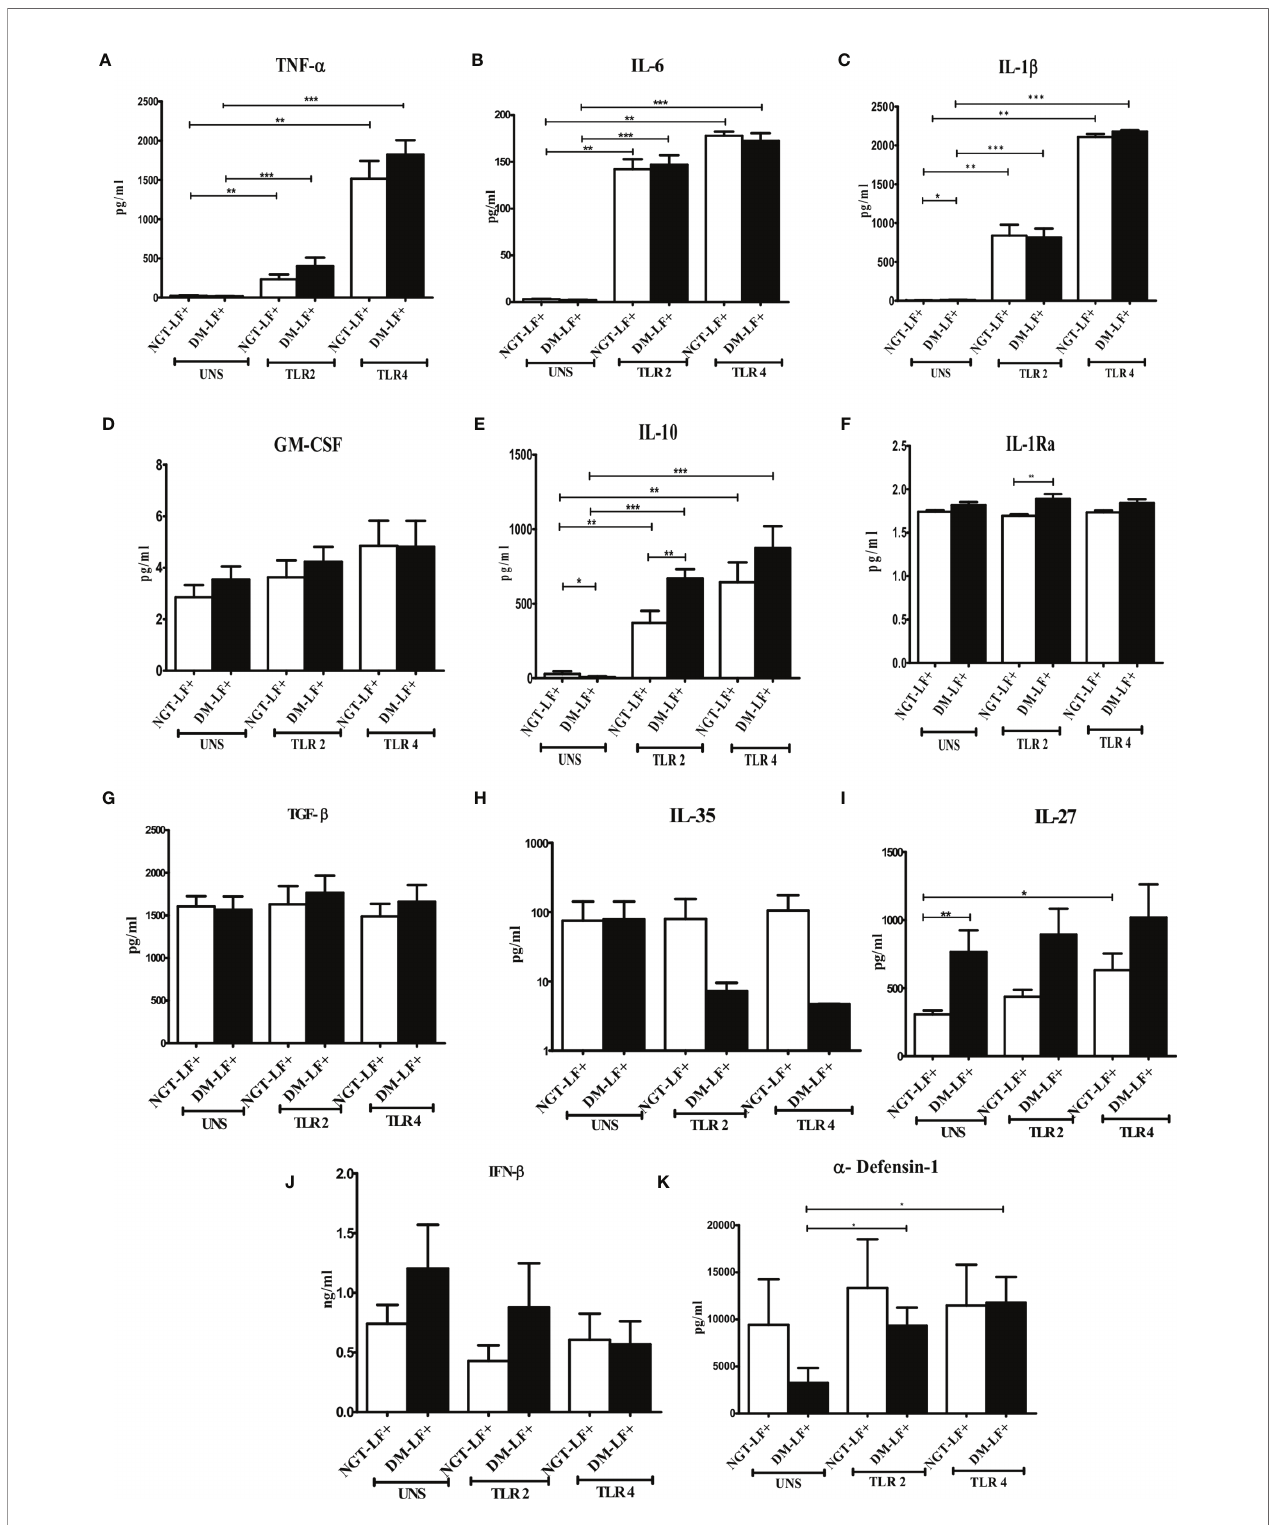
FIGURE 1 | Effect of diabetes on the TLR-induced secretion of pro- and anti-in fl ammatory cytokine type 1 interferons and defensins in LF+ subjects. Bar graph showing Unstimulated (UNS), TLR2-, and TLR4-induced secretion of TNF- a (A) , IL-6 (B) , IL-1 b (C) , GM-CSF (D) , IL-10 (E) , IL-1Ra (F) , TGF- b (G) , IL-35 (H) , IL-27 (I) , IFN- b (J) , and a -defensin (K) in the supernatants of blood cultures in NGT-LF+ and DM-LF+ subjects. Statistical signi fi cance was determined by non-parametric Mann – Whitney U test and p < 0.05 was considered signi fi cant. * p < 0.05; ** p < 0.01; *** p <